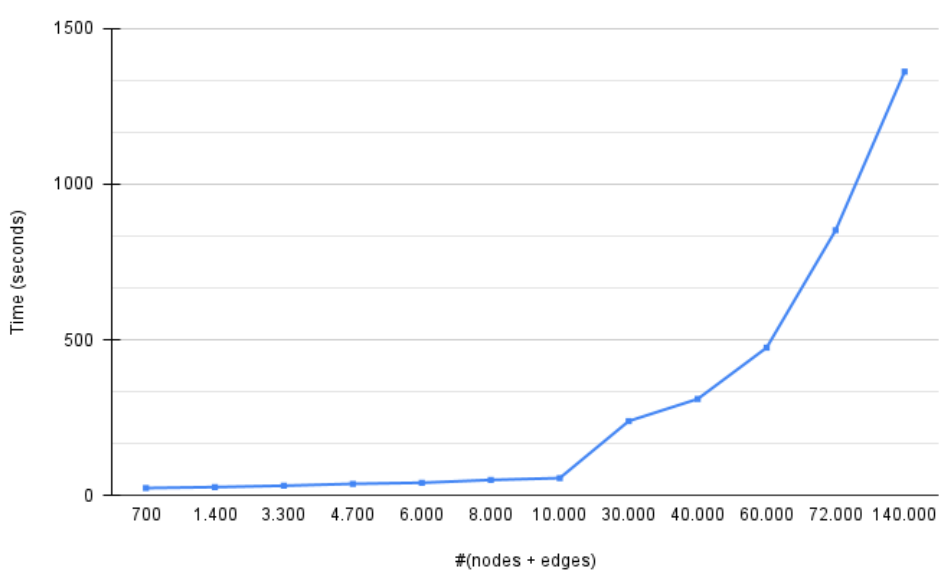
Figure 13. Execution times in seconds needed to build and visualize small and large graphs.